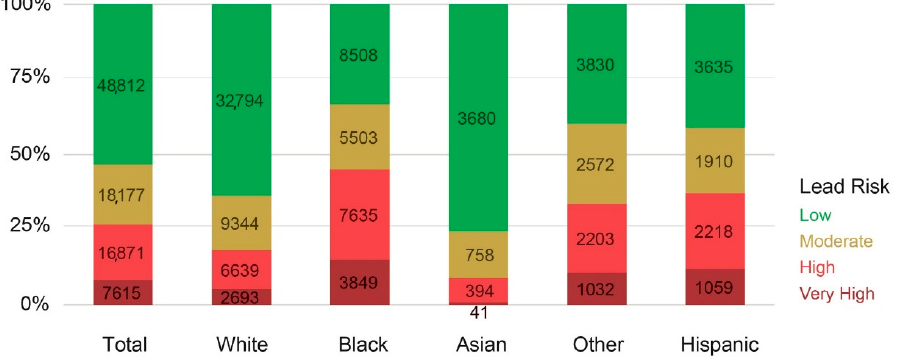
Figure 7 . Lead risk and children under 5 by race . Figure 7. Lead risk and children under 5 by